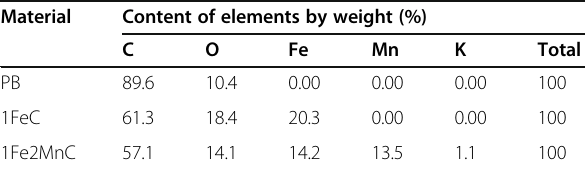
Table 2 EDS analysis results